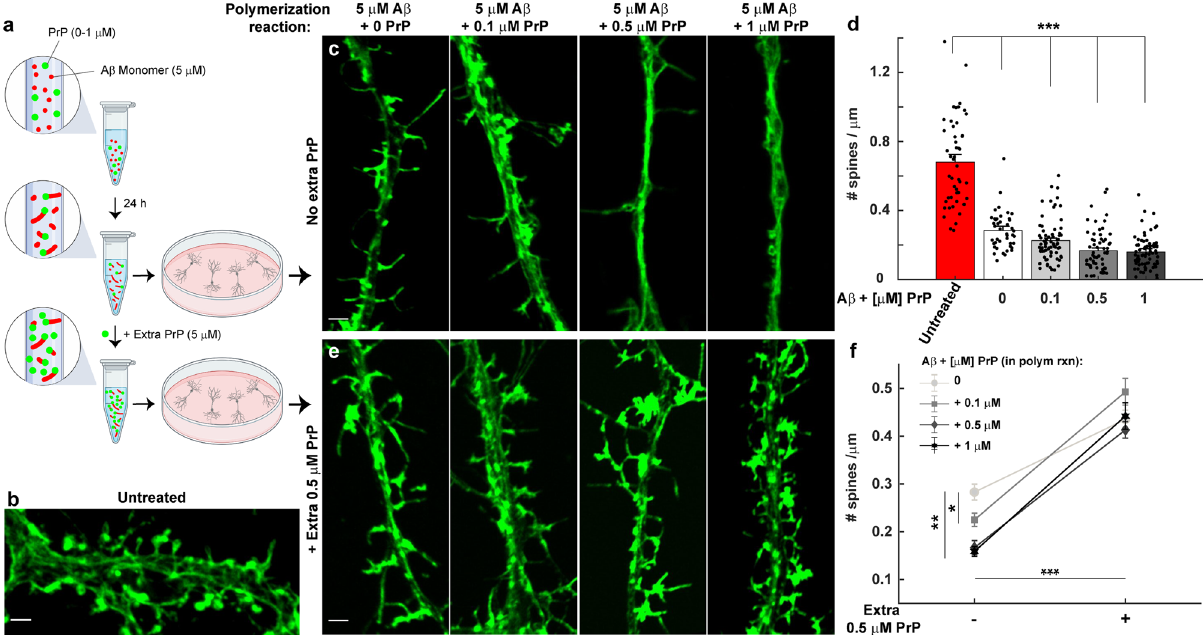
Fig. 6 Neurotoxicity assay of A β fi brils polymerized in the presence of PrP. a Schematic representation of a neurotoxicity assay, in which A β monomers (5 μ M) were polymerized in the presence of PrP (0, 0.1, 0.5, and 1 µ M) for 24 h. The resulting fi brils were then either diluted ten-fold directly into neuronal culture medium to give a fi nal A β concentration of 500 nM (monomer-equivalents); or they were fi rst incubated for 10 min with additional recombinant PrP to give a total concentration of 5 µ M (equimolar to A β ) before dilution into the culture medium ( fi nal PrP concentration of 0.5 µ M). Neurons were fi xed after 1 h of treatment and stained with Alexa 488-labeled phalloidin to visualize dendritic spines. The schematic was created with BioRender.com. b Confocal image of untreated hippocampal neurons, showing many normal, mushroom-shaped dendritic spines. c Neurons treated with A β fi brils polymerized in the presence of 0, 0.1, 0.5, and 1 μ M PrP. Inclusion of PrP in the polymerization reaction increases the toxicity of the resulting fi brils, re fl ected in retraction of dendritic spines. Scale bars 2 μ m. d Quantitation of spine number per μ m for neurons treated as in ( c ). Data are presented as mean ± S.E. *** P < 0.001 (two-sided Student ’ s t -test). The numbers of biological independent samples in each condition is ≥ 2 and the number of analyzed neurites in control, - PrP, + 0.1 µ M PrP, + 0.5 µ M PrP and + 1 µ M PrP condition are: X = 48, 42, 72, 61, and 76, respectively. e A β polymerized in the presence of PrP, as in ( c , d ), were incubated with extra recombinant PrP (5 µ M) before dilution into the neuronal culture medium. Incubation with excess PrP at the end of the polymerization reaction blocks the toxicity of fi brils. f Quantitation of spine number per μ m with and without addition of excess recombinant PrP. Data are presented as mean ± S.E. * P < 0.05, ** P < 0.01, and *** P < 0.001 (two-sided Student ’ s t -test). This experiments repeated twice and the number of analyzed neurites in - PrP, + 0.1 µ M PrP, + 0.5 µ M PrP and + 1 µ M PrP condition are: X = 59, 44, 55, and 53,